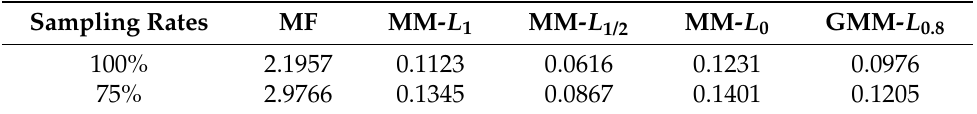
Table 2. The ENT of the Combat Vehicle.